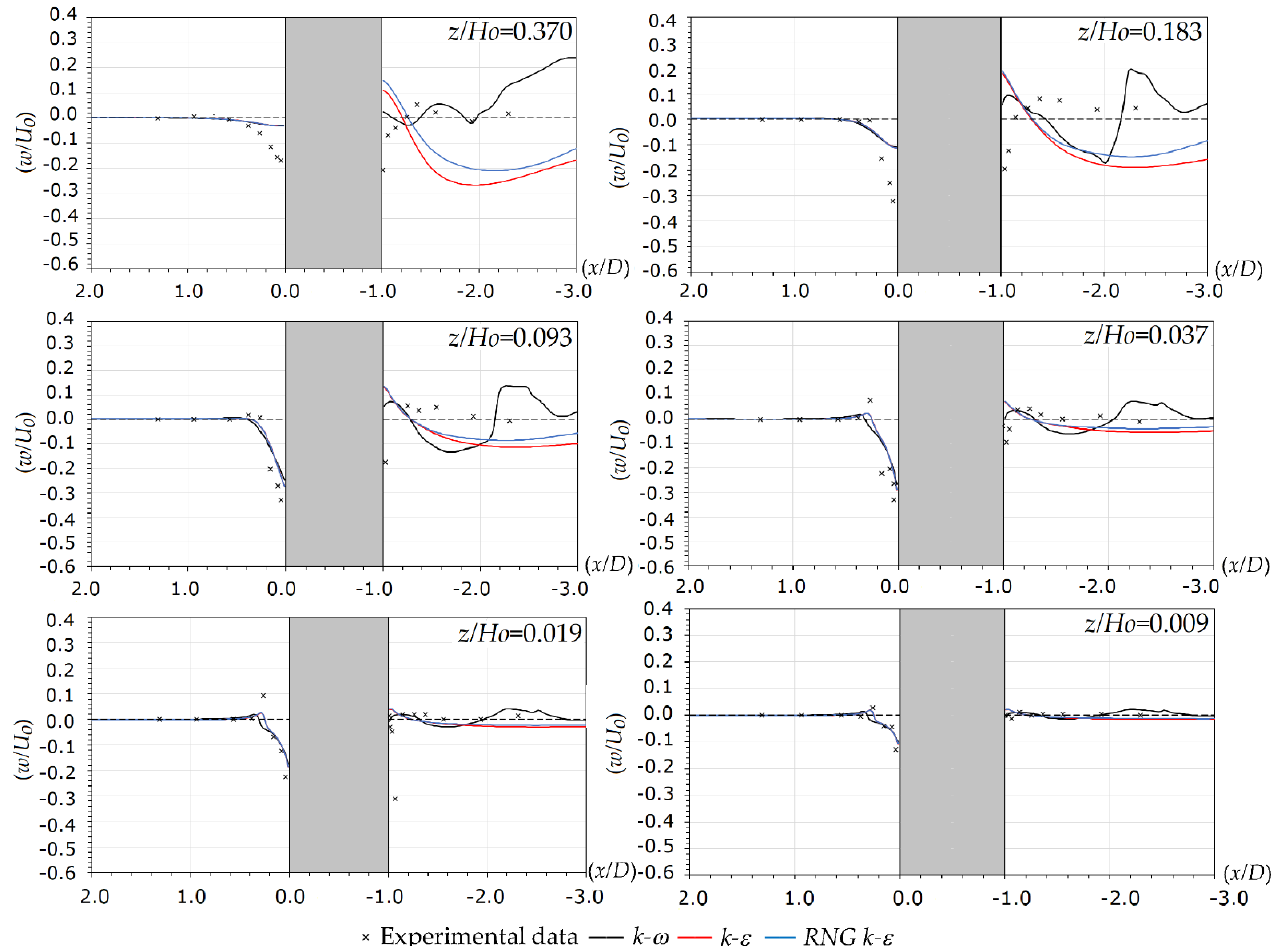
Figure 7. Validation versus [30] experimental measurements at the plane of symmetry.